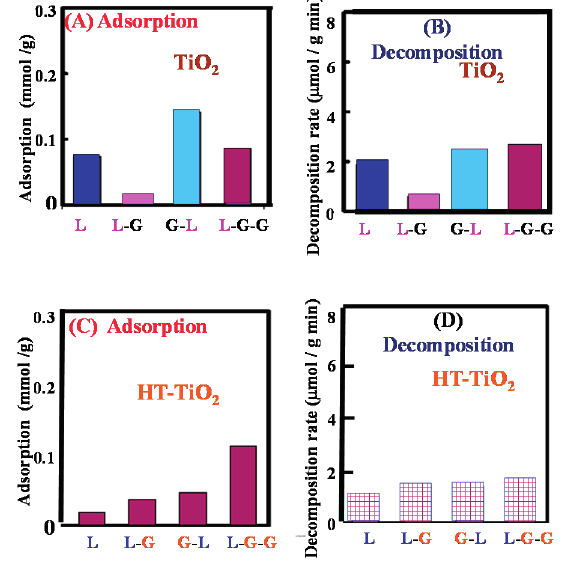
Figure 14. Equilibrium adsorption and rate of decomposition under the UV irradiation measured at 297 K for Leu, Leu-Gly, Gly-Leu, and Leu-Gly-Gly in the aqueous suspensions of TiO 2 ; ( A , B ) for untreated TiO 2 and ( C , D ) for HT-TiO 2 (TiO 2 calcined at 973 K). Reprinted with permission from [43] © 2014 American Chemical Society.